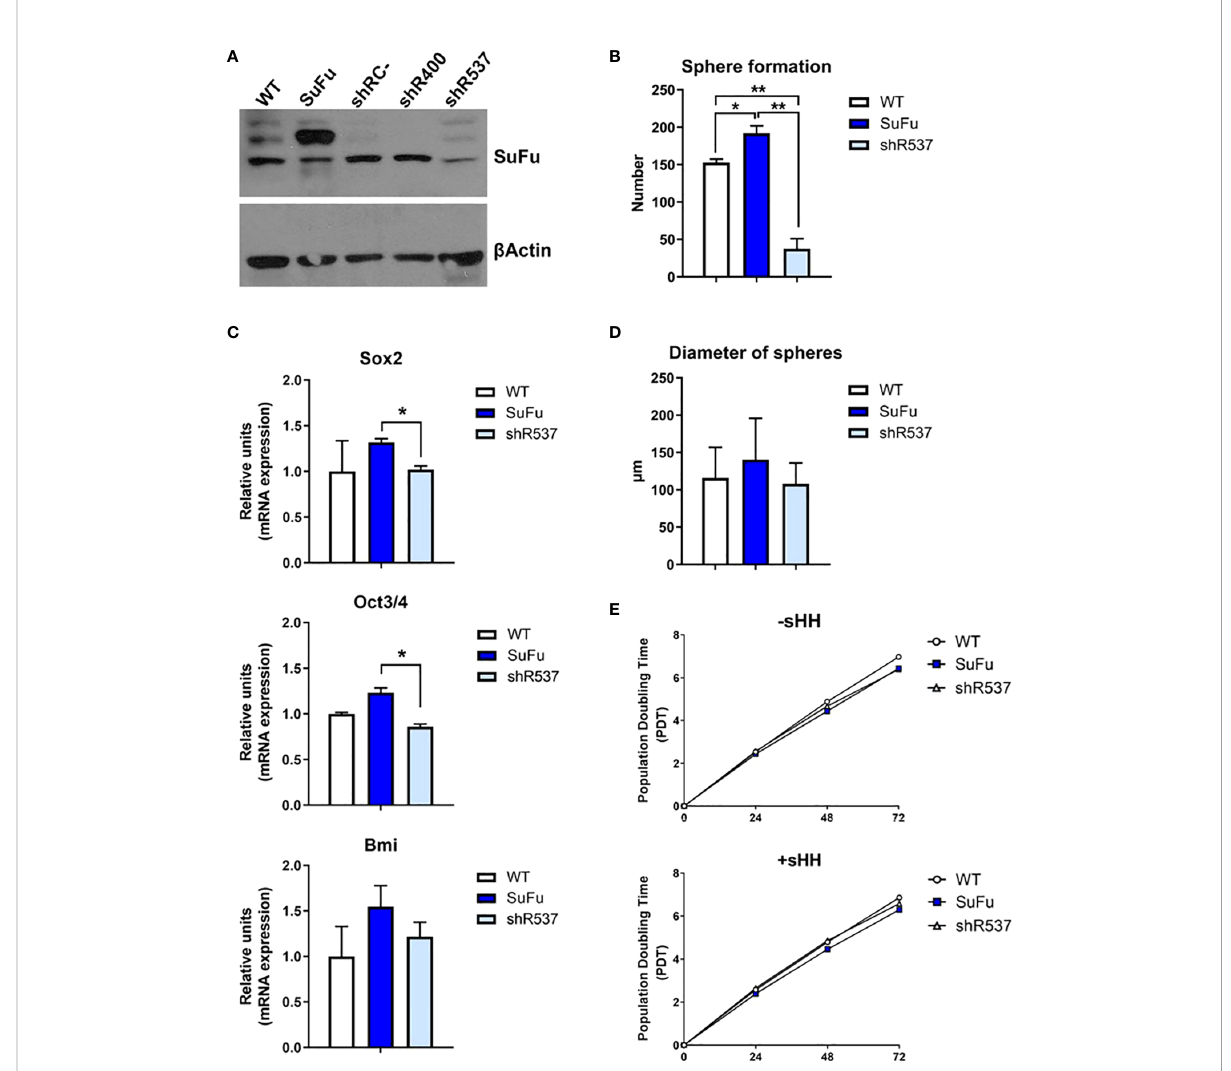
FIGURE 2 (A) Western blot analysis for SuFu using GB18 CSCs samples transfected with overexpression and downregulation vector. CSCs transfected with empty expression vector (shRC-) was used as control. (B) Number of spheres formed by GB18 CSCs (C) Sox2 , Oct3/4 , and BMI mRNA levels in GB18 CSCs by qRT-PCR. (D) Diameter of spheres of GB 18CSCs. (E) Duplication time in basal conditions ( − sHH) and in the presence of ligand (+sHH). WT, SuFu, and shR537 CSCs were analyzed. Data are shown as mean ± S.D. and are representative of two independent experiments. P-values were calculated based on the two-tailed two-sample t test. *P < 0.05 and **P <